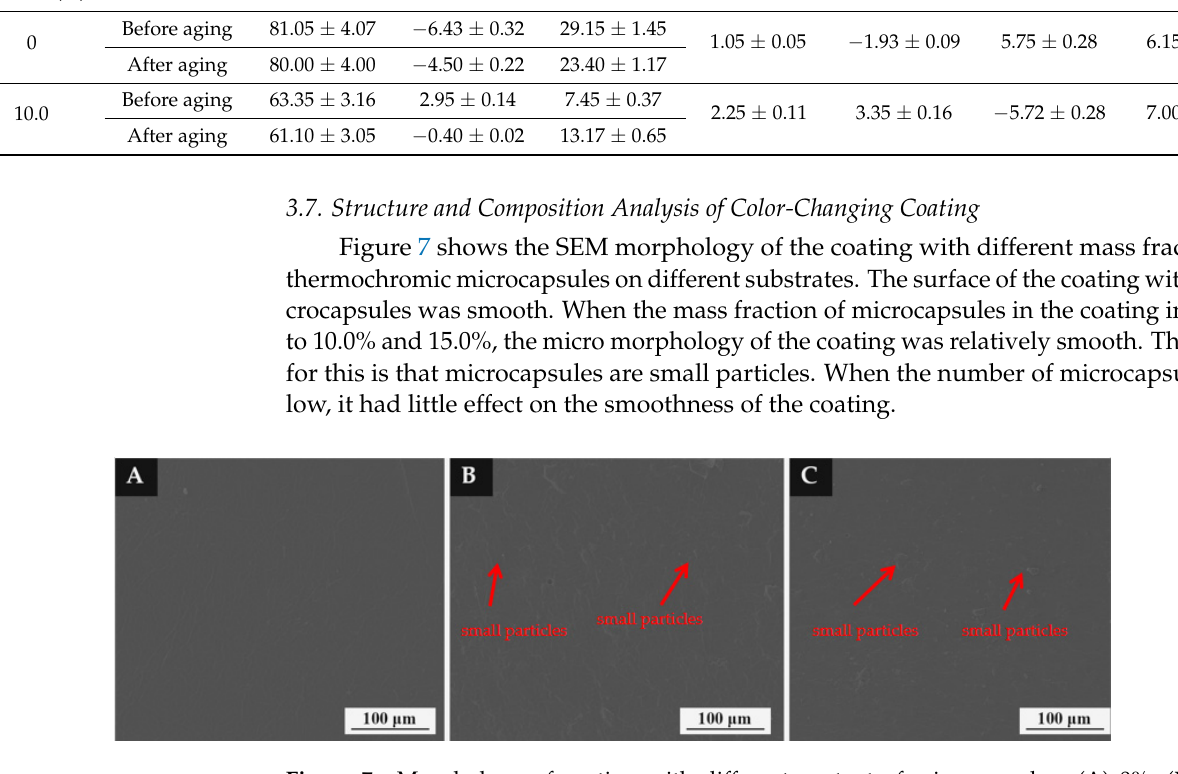
Figure 7. Morphology of coating with different content of microcapsules: ( A ) 0%, ( B ) 10.0%, ( C ) 15.0%.